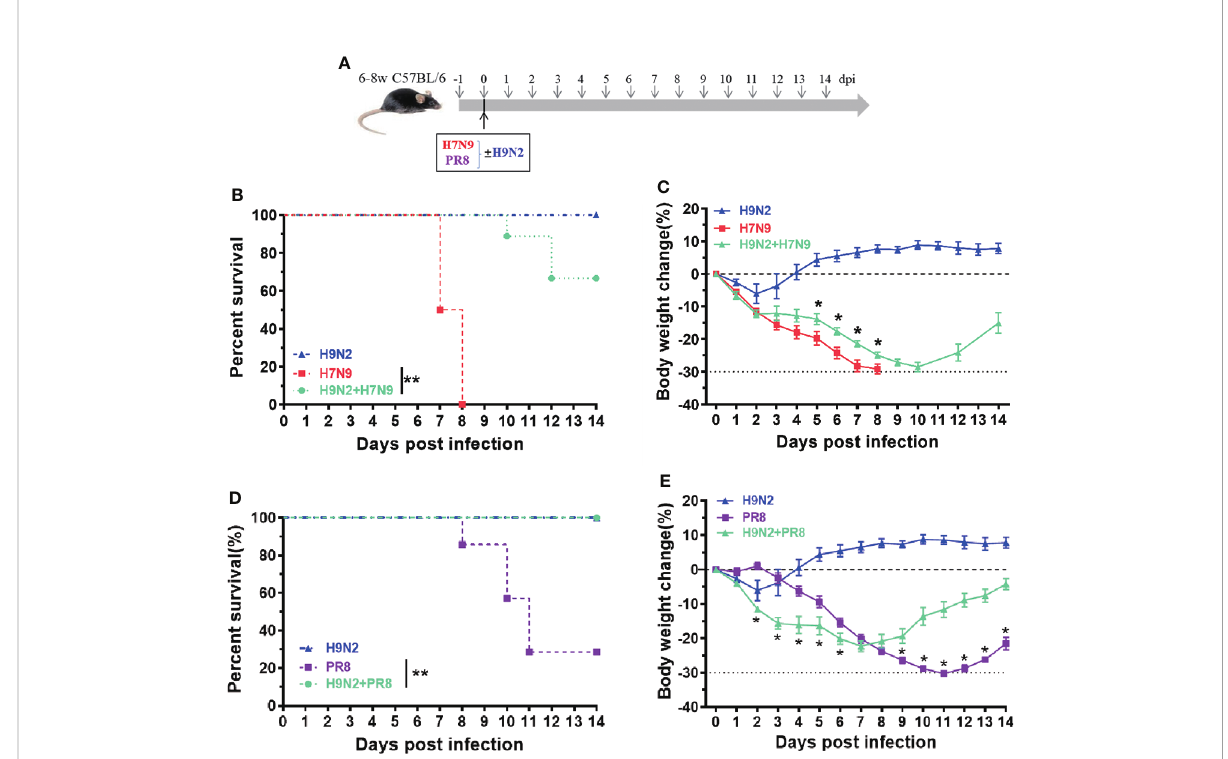
FIGURE 4 An experimental utilization of H9N2-raised early innate immunity to protect against heterologous in fl uenza challenge. (A) The schematic diagram of a co-infection experiment. (B, C) Comparison of survival (B) and body weigh change (C) among mice infected with H7N9 alone, H9N2 alone, or a combination of H7N9 and H9N2. (D, E) Comparison of survival (D) and body weigh change (E) among mice infected with PR8 alone, H9N2 alone, or a combination of PR8 and H9N2. n=7-10 for each group, Data are expressed as mean ± SEM. *P < 0.05 by t test for body weight change at indicated time point between H7N9/PR8 infected group and H7N9/PR8+H9N2 co-infected groups. **P < 0.01 by Log-rank (Mantel-Cox) test for survival